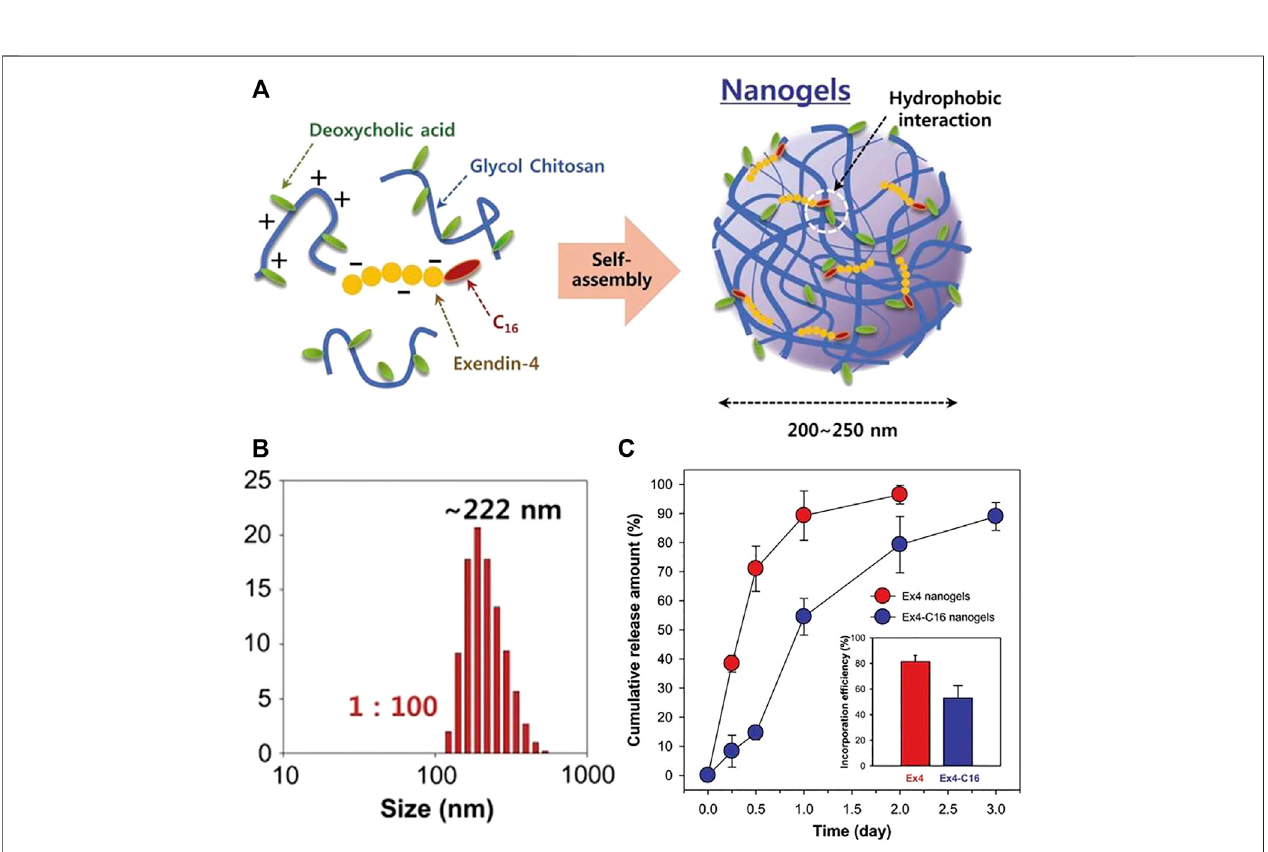
Frontiers in Bioengineering and Biotechnology |